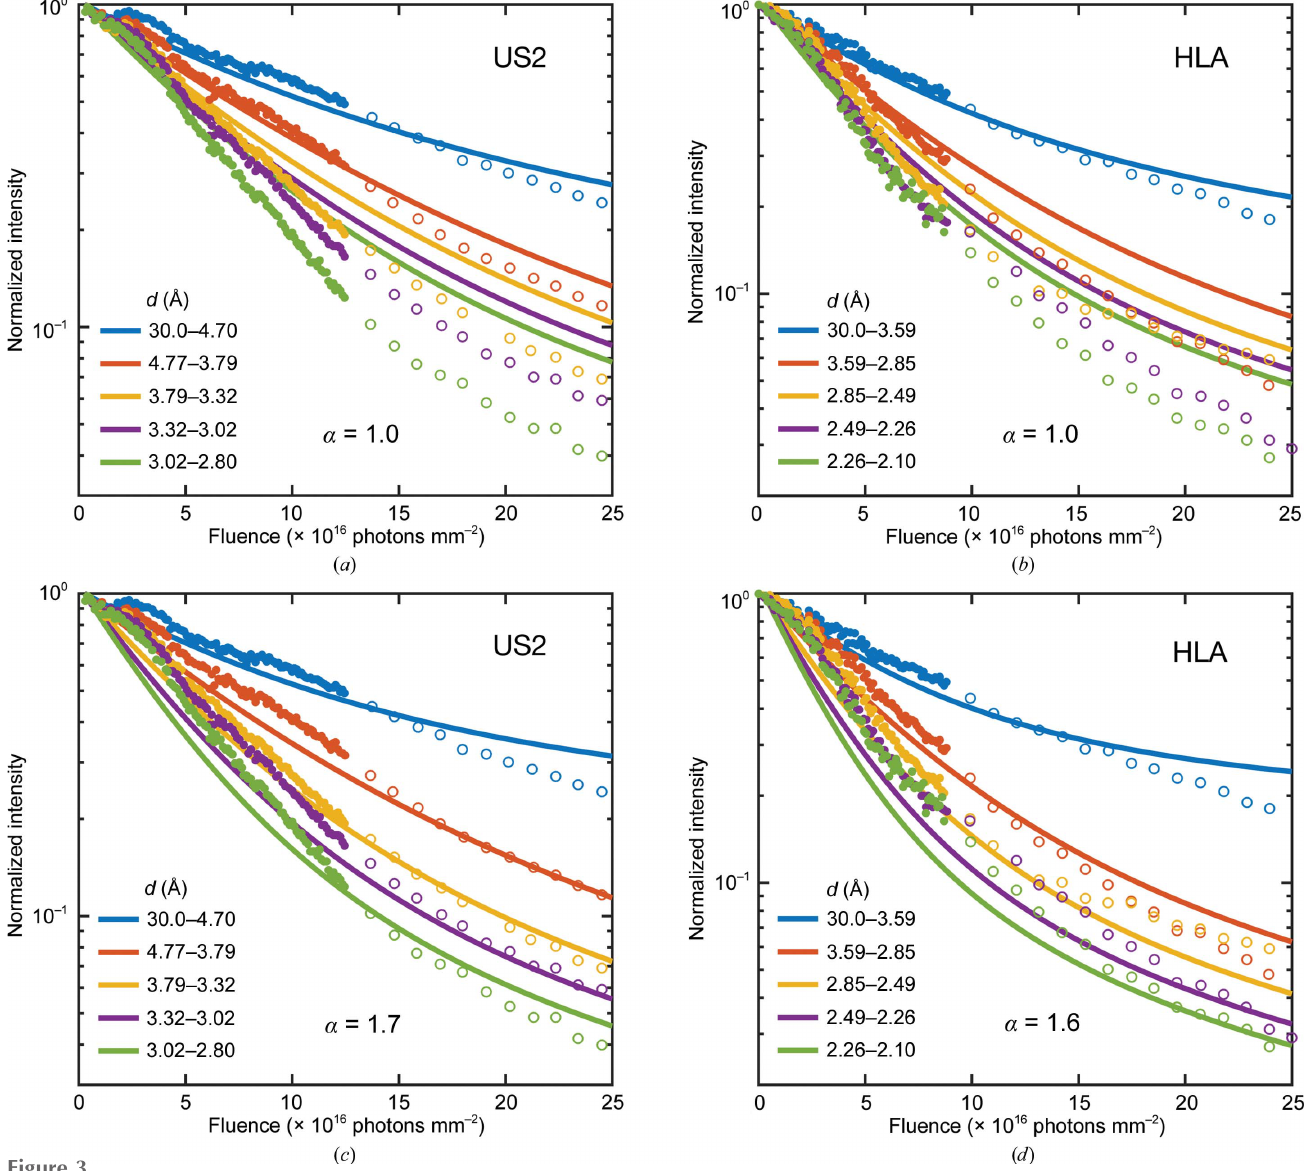
Figure 3 Experimental data in the low-dose (solid circles) and high-dose (open circles) regions for integrated intensity in resolution shells versus incident fluence (in photons mm (cid:2) 2 , proportional to dose) reported by Sliz et al. (2003) (Fig. 1 in the original manuscript) for crystals of US2 and HLA at 100 K. The solid lines indicate results from simulations assuming a top-hat incident beam profile in the horizontal direction and a Gaussian profile in the vertical direction (based on descriptions of the experimental setup), with ( a ), ( b ) (cid:2) = 1 and ( c ), ( d ) ‘best-fit’ values chosen based on visual